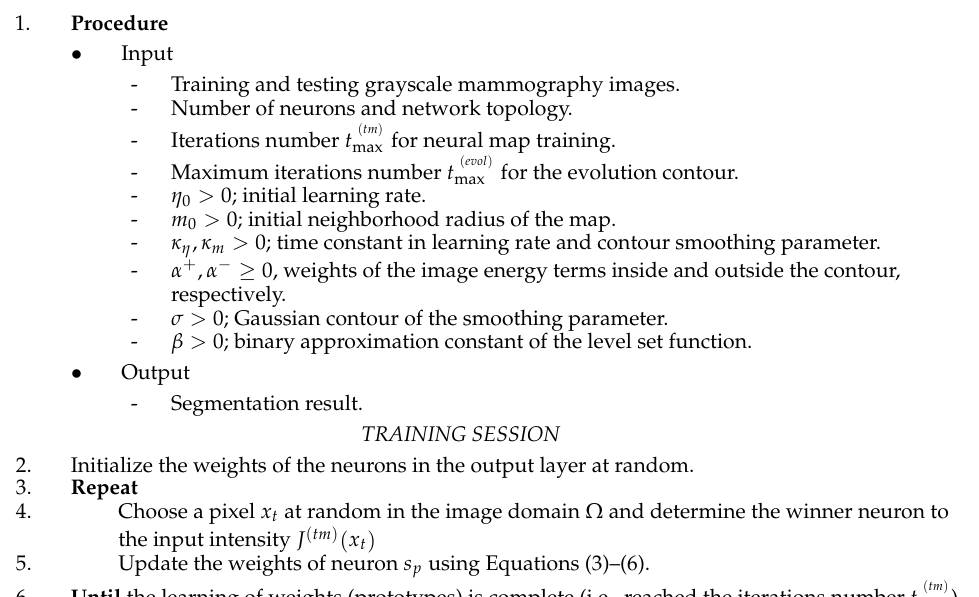
Algorithm 1: Algorithm for the SSOM Model.